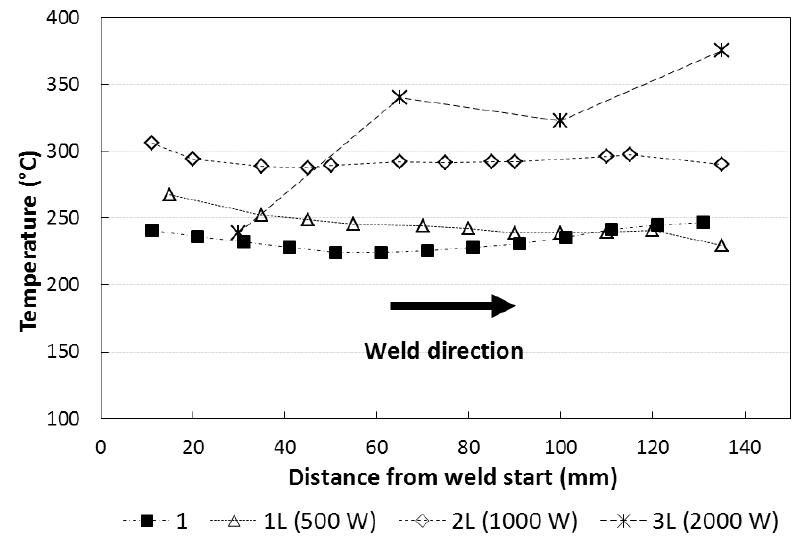
Figure 11. Maximal temperature at 15 mm from weld line during the welding process. (The 3L type specimen temperatures were measured using thermocouple while the others by infrared camera)